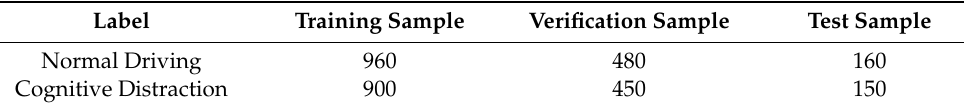
Table 2. Number of samples in each set.